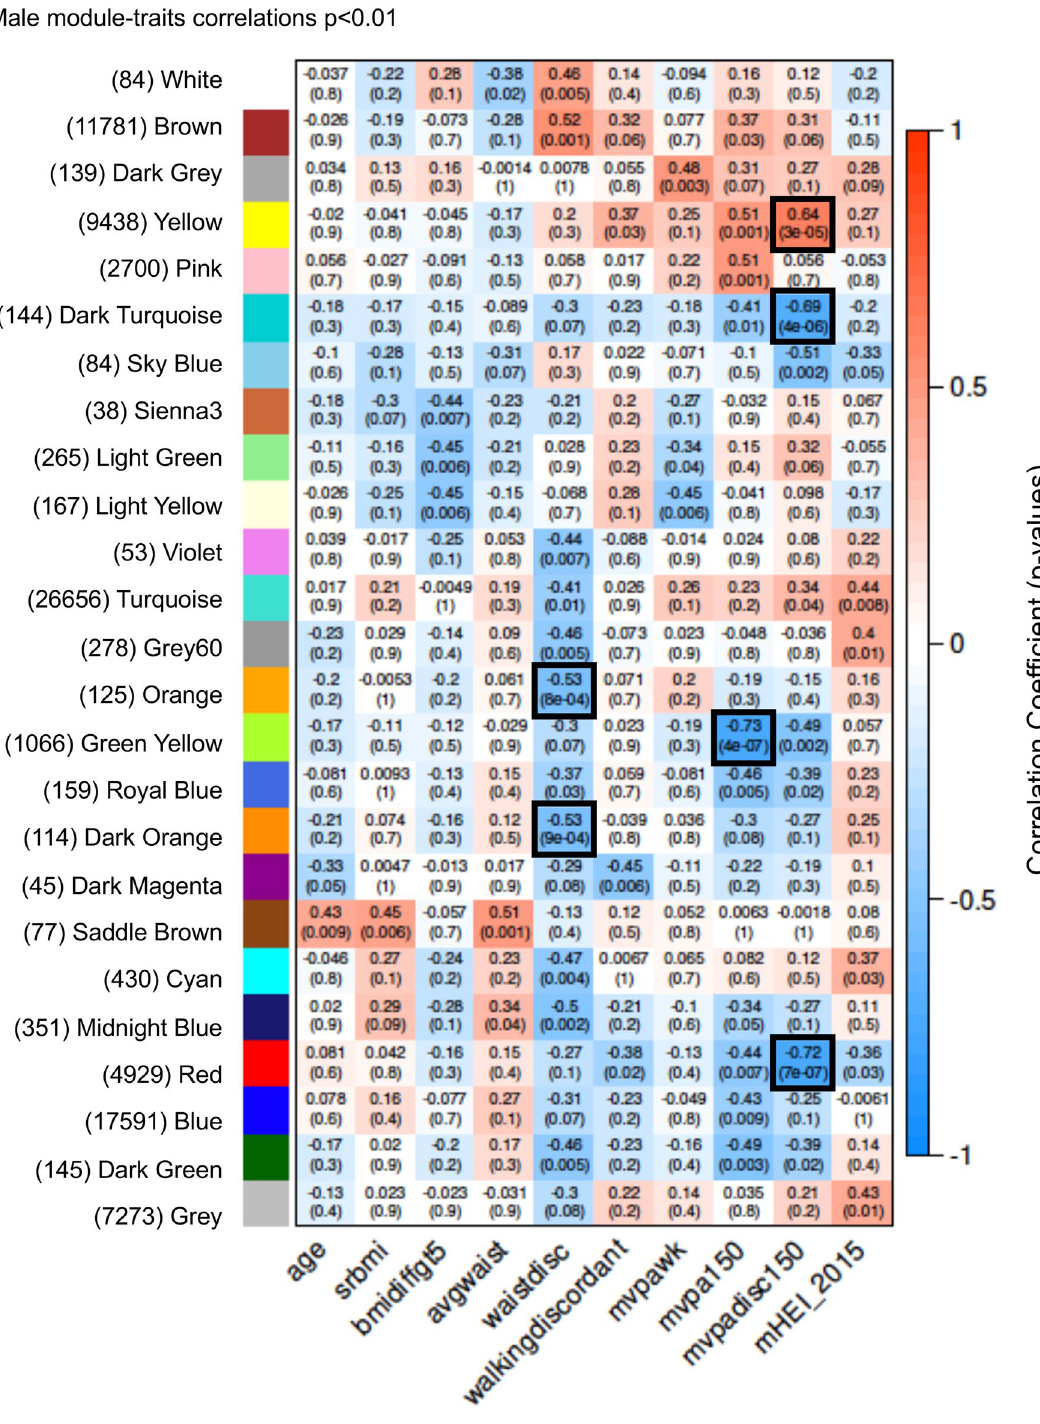
Figure 6. Male module-traits correlations p < 0.001. Rows and columns removed if no correlation met